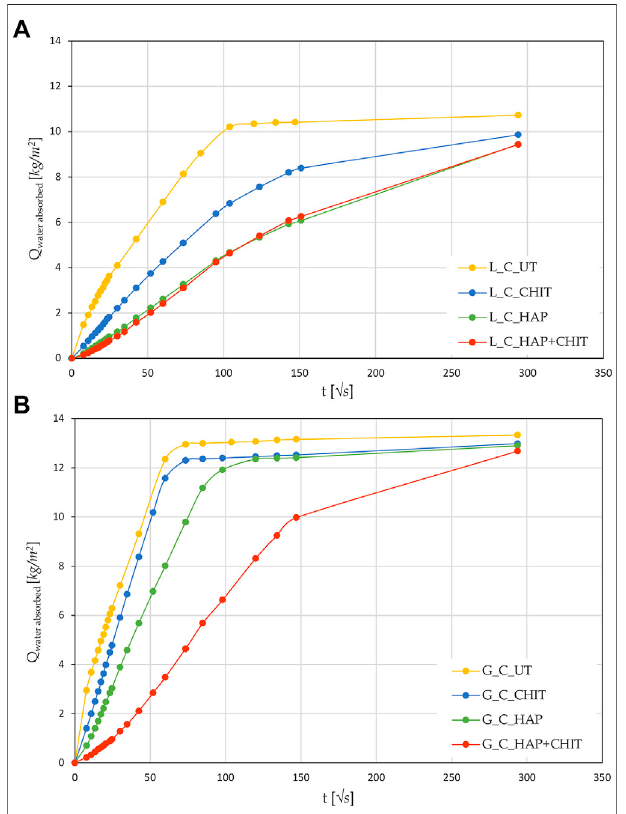
FIGURE 1 | Capillary water absorption curves for the untreated (UT) and treated cylindrical samples for (A) Lecce stone and (B) Globigerina limestone. Values are averages for at least two samples.